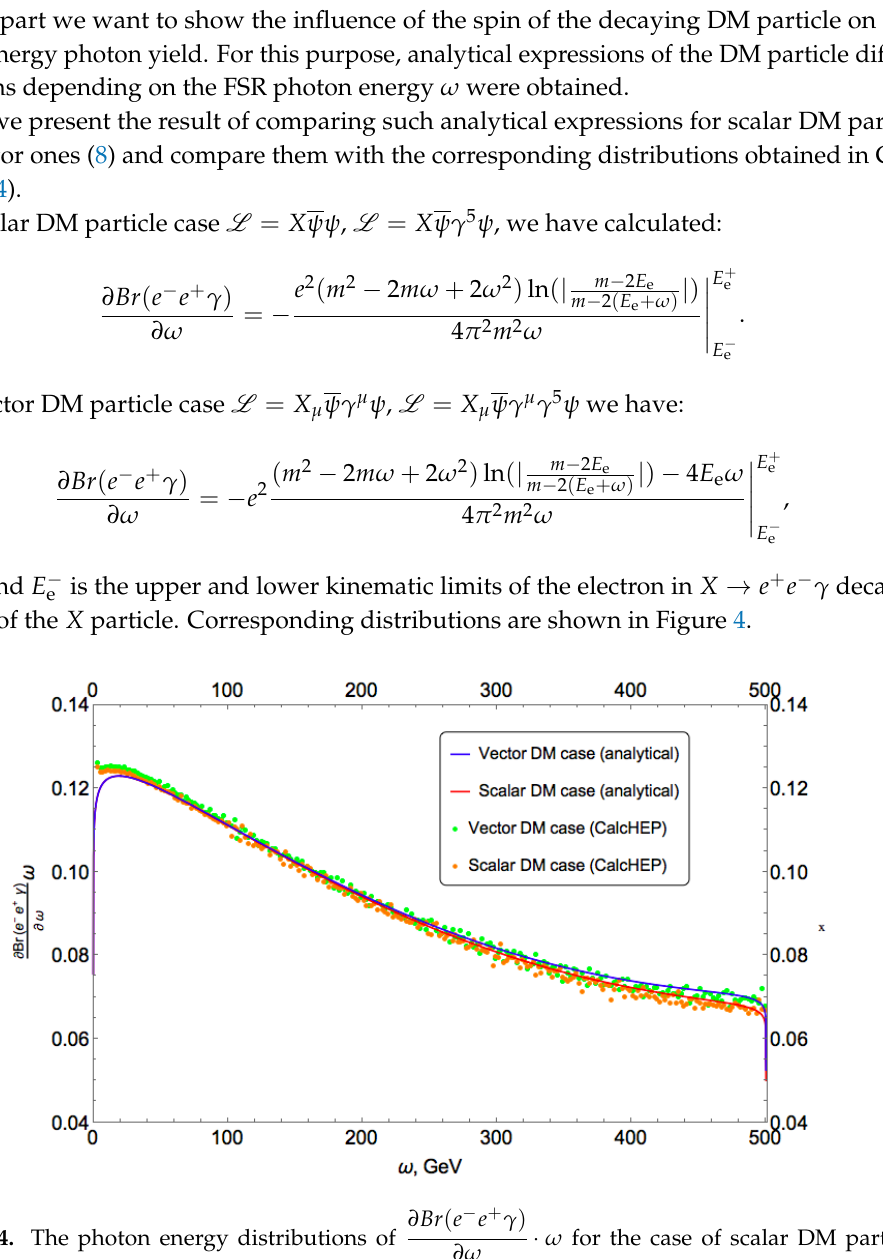
Figure 4. The photon energy distributions of (red) and vector DM particle (blue) decay with corresponding distributions obtained in CalcHEP. For m = 1000